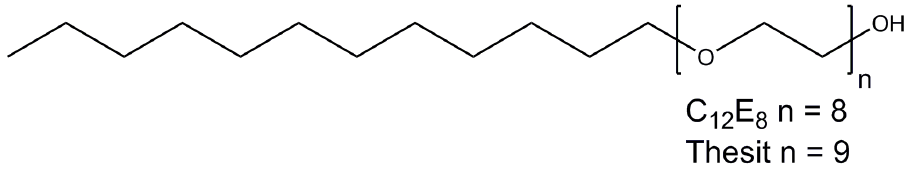
Figure 8. Structure of C 12 E 8 and C 12 E 9 (chemical formula is (C 2 H 4 O)nC 12 H 26 O, n ~8 or 9).